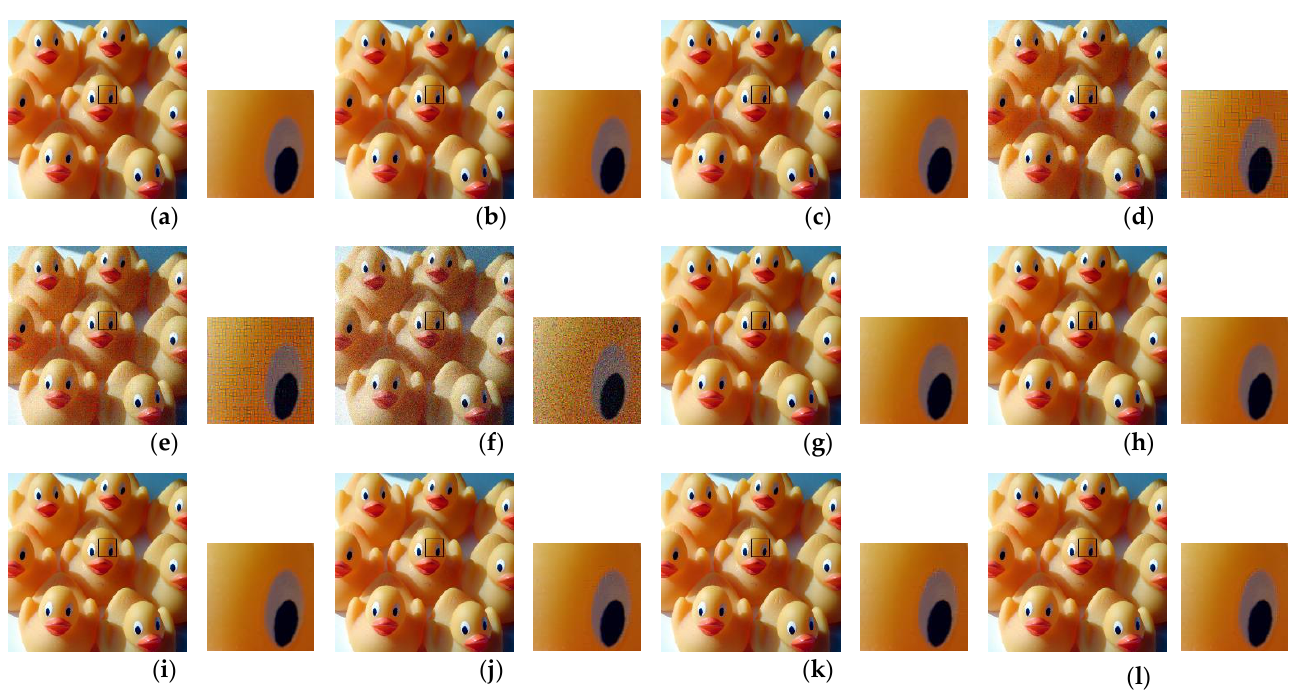
Figure 10. Images recovered from PE methods using different block sizes. The JPEG quality factor is 100. ( a ) The original image. ( b ) Image recovered from the plain image. ( c – f ) Images recovered from the Color – EtC method with block sizes (16 × 16, 8 × 8, 4 × 4, and 2 × 2), respectively. ( g – i ) Images recovered from the GS – EtC method with block sizes (8 × 8, 4 × 4, and 2 × 2), respectively. ( j – l ) Images recovered from the proposed with block sizes (8 × 8, 4 × 4, and 2 × 2), respectively. The boxed region in each image is zoomed in and shown on its left side.